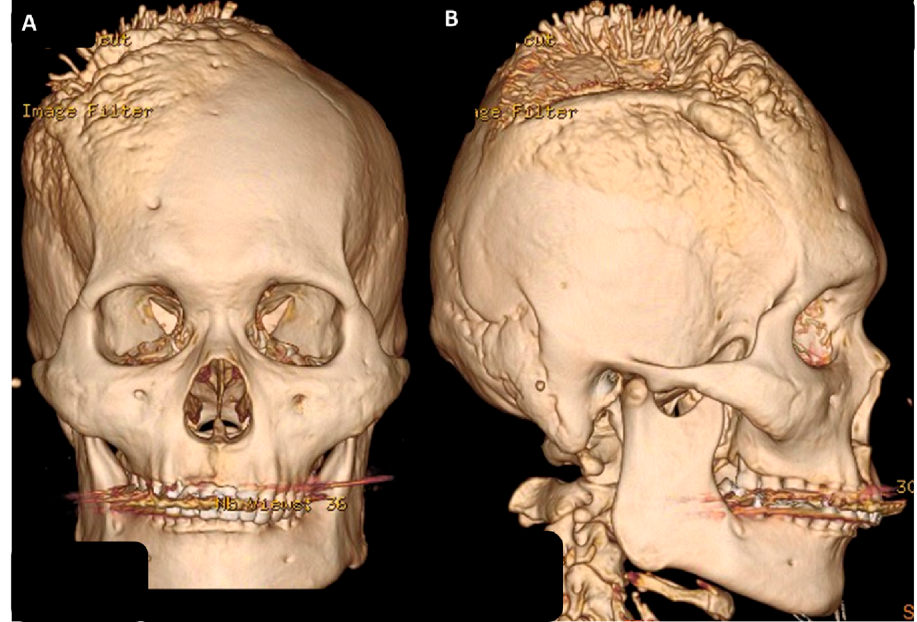
Figure 1. Brain CT with reconstruction image showed a huge extra-cranial osteophyte lesion over right skull bone: ( A ) Anterioposterior (AP) view; ( B ) lateral view.